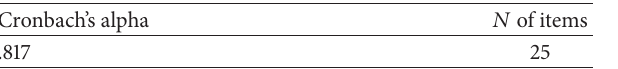
Table 2: Results reliability